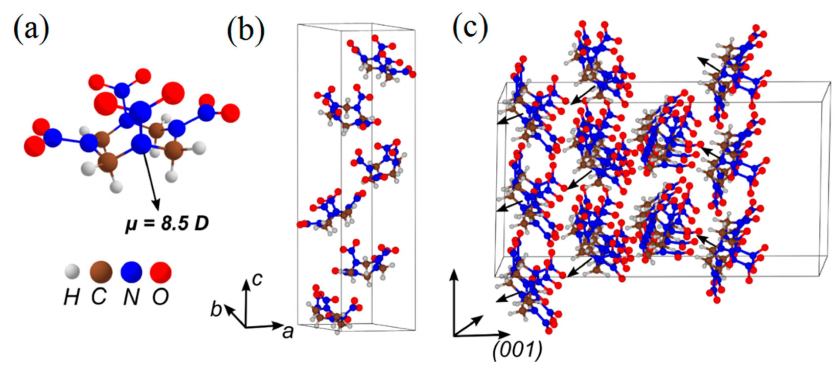
Figure 6. The structure of ( a ) a boat conformer of δ -HMX molecule with the dipole moment µ ;